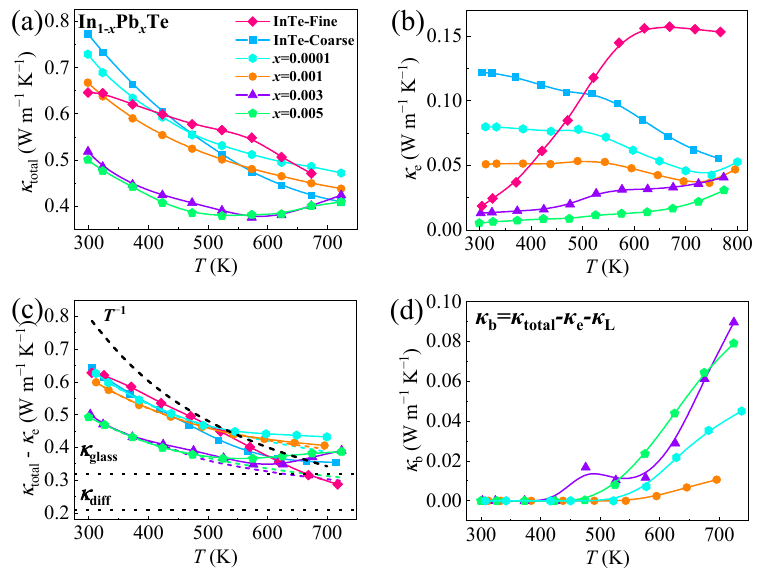
Figure 5. Temperature dependence of the thermal properties of the sieved coarse In 1- x Pb x Te ( x = 0, 0.0001, 0.001, 0.003, 0.005) and the sieved fine InTe. ( a ) Total thermal conductivity, ( b ) electron thermal conductivity, ( c ) lattice thermal conductivity. The solid part is calculated by κ otal - κ e , and the dashed part is obtained by fitting the solid part within 300–400 K according to aT − 1 + b , which is then extrapolated in the subsequent temperature range. The dotted lines are the minimum thermal conductivity calculated by Chaill model and diffusion model [45,46]. ( d ) Bipolar thermal conductivity.